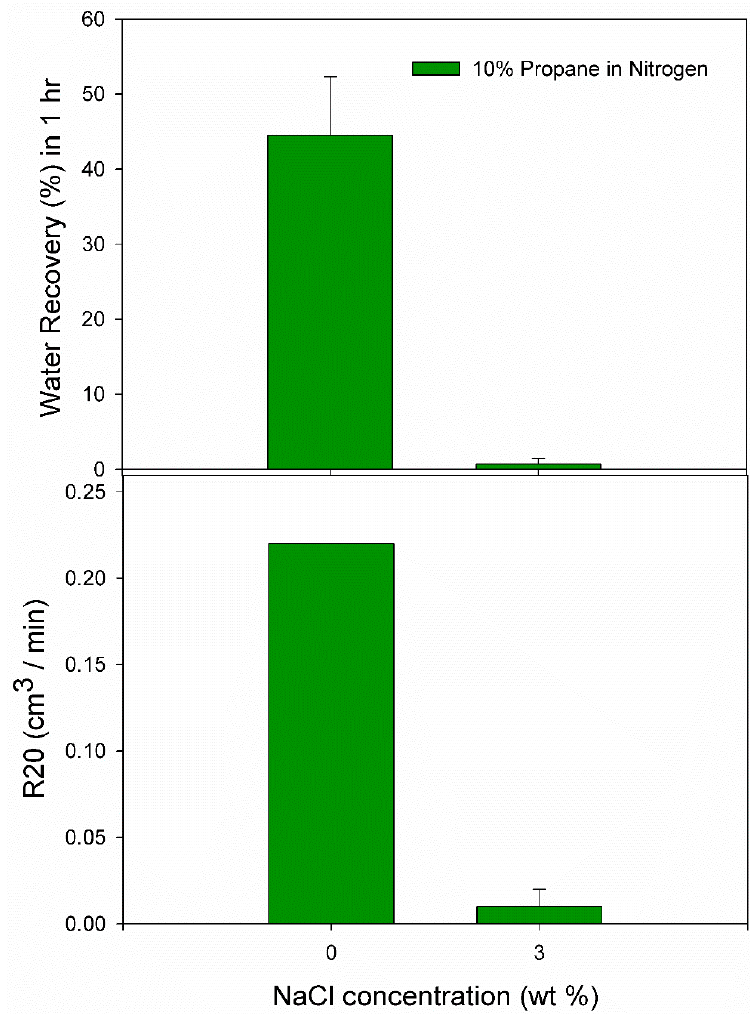
Figure 4. Effect of NaCl concentration on water recovery for the 10% propane in nitrogen gas mixture.